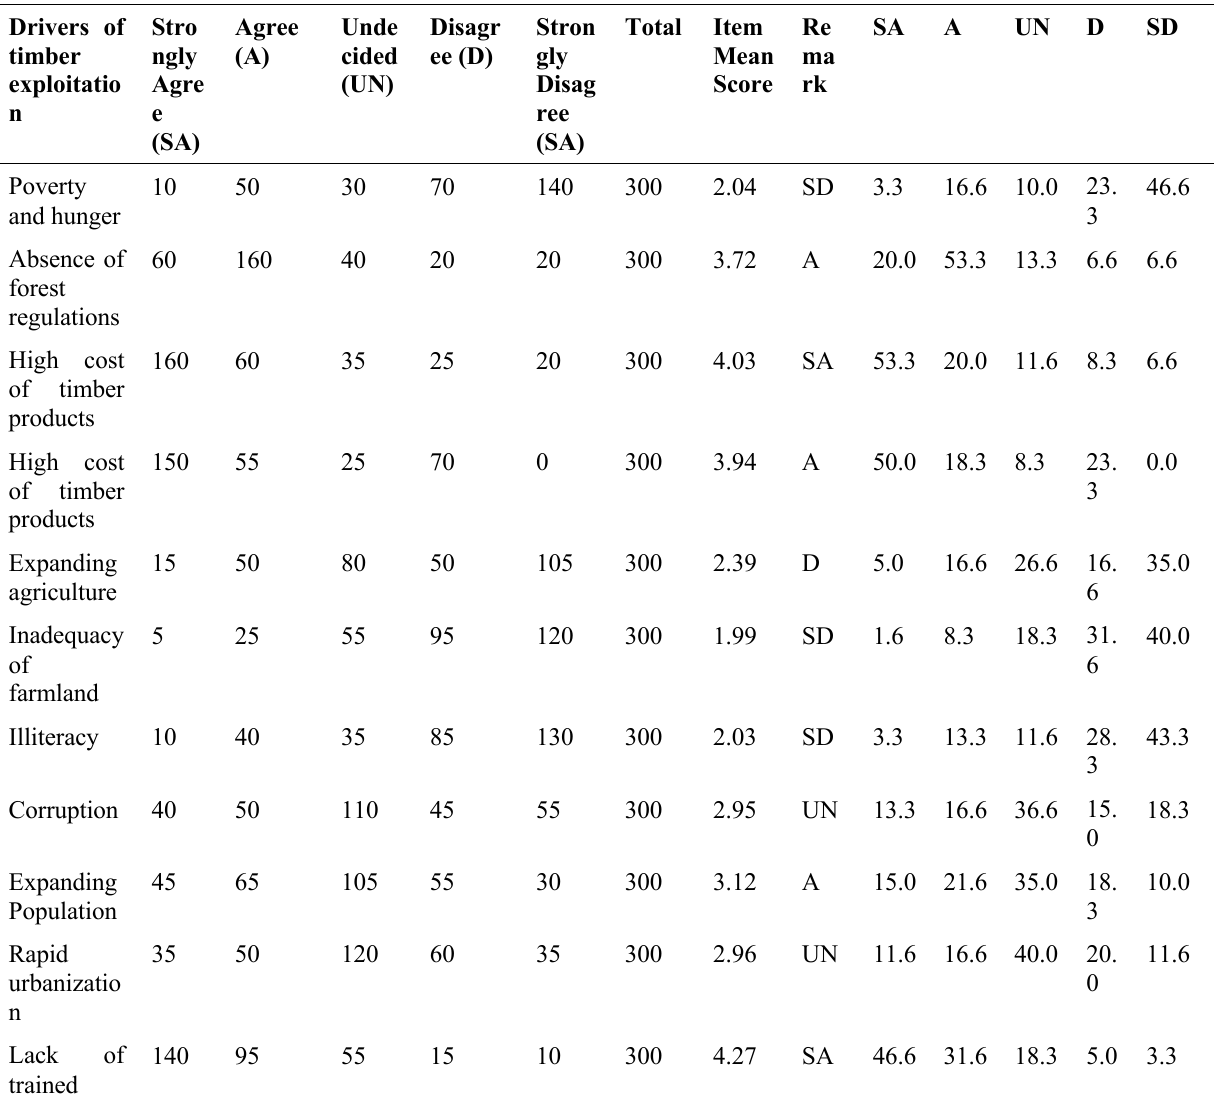
Table 2: Respondents' Perception of the Drivers of Timber Exploitation. Drivers